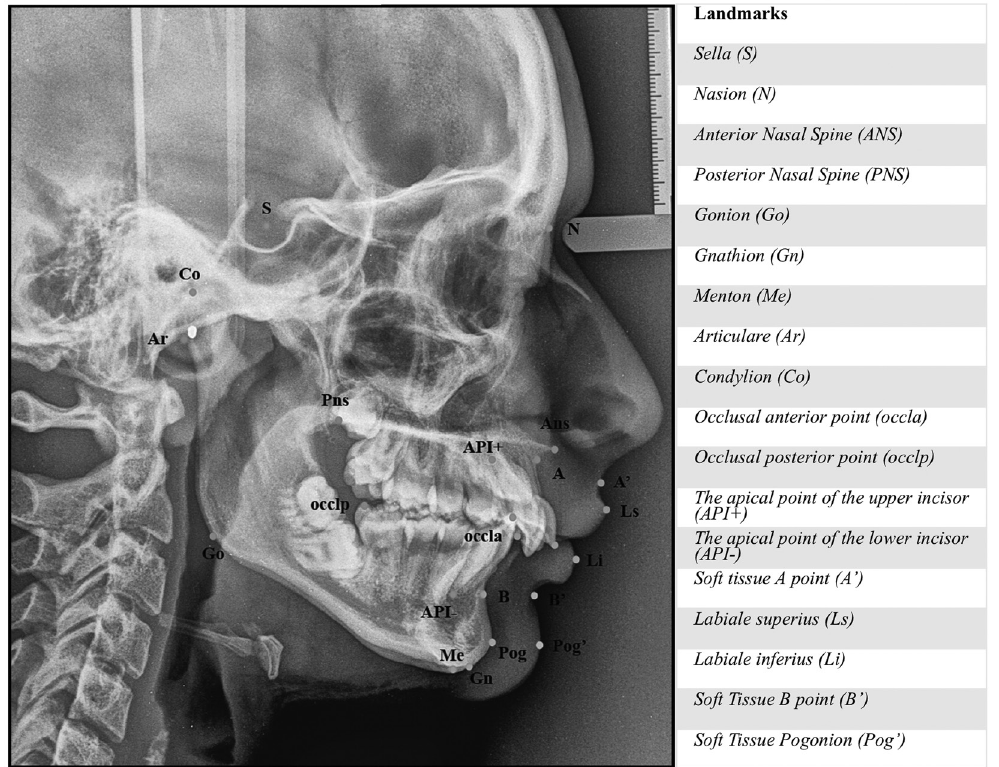
Figure 3. Landmarks.